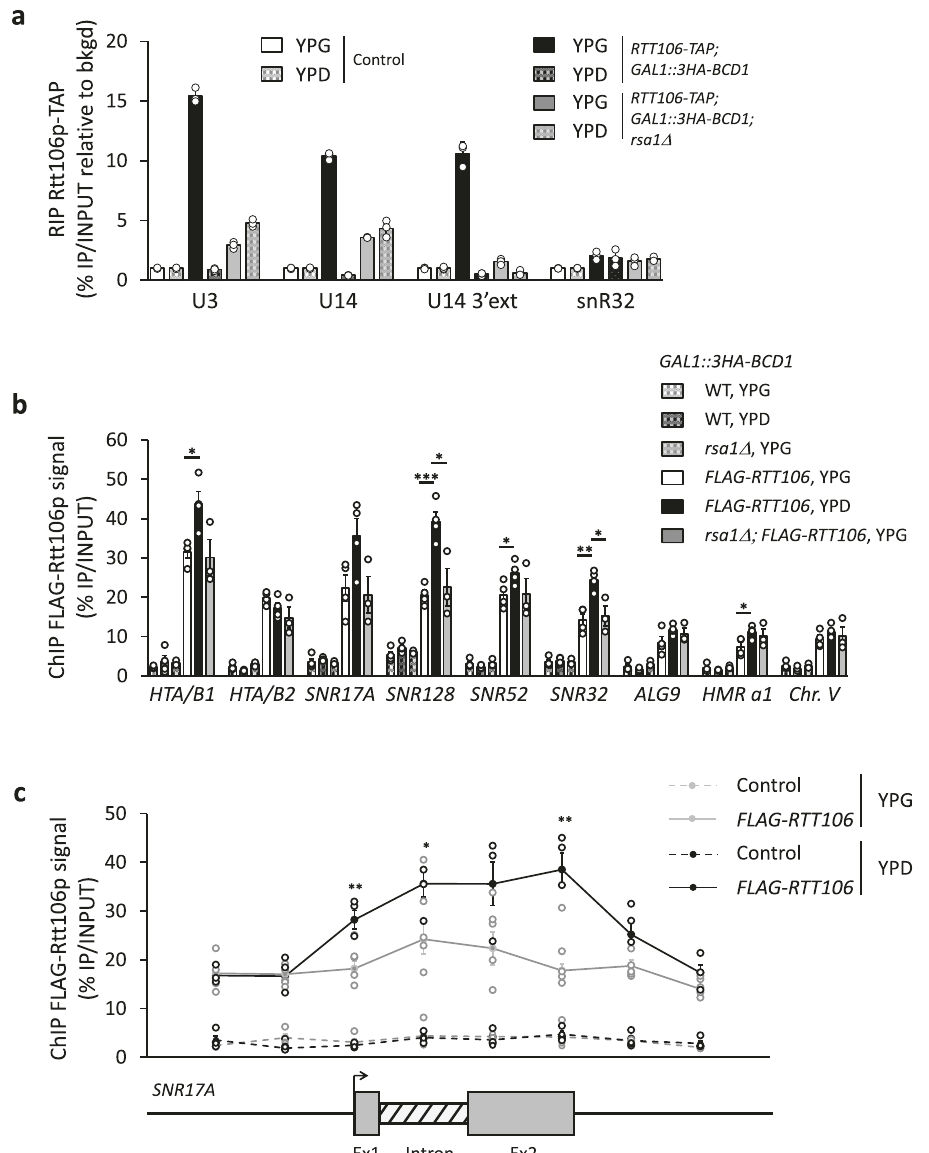
Fig. 3 Interaction of Rtt106p with selected transcripts and loci. a RNA immunoprecipitation (RIP) assays were performed on extracts prepared from RTT106-TAP ; GAL1:3HA-BCD1 cells disrupted ( rsa1 Δ ) or not of the RSA1 ORF. The cells were cultivated in the presence of galactose (YPG) or shifted to a glucose-containing medium (YPD) for 6 h before preparation of the extract. IP was performed using IgG-sepharose beads. RNAs retained on beads were quanti fi ed by RT-qPCR as described in the Methods section. The snoRNAs and pre-snoRNAs analyzed are indicated. b Chromatin immunoprecipitation (ChIP) assays were performed on yeast GAL1:3HA-BCD1 cells transformed with recombinant plasmid FLAG-RTT106 ; with ( rsa1 Δ ) or without the disruption of the RSA1 ORF. Cells were cultivated in YPG or shifted to YPD medium before ChIP assays. Cells expressing nontagged Rtt106p ( GAL1:3HA-BCD1 and GAL1:3HA-BCD1; rsa1 Δ ) were used as controls and IP was performed using anti-FLAG antibody. The loci analyzed by qPCR analysis are indicated. c Chip assays performed as in panel b on GAL1:3HA-BCD1 cells transformed with recombinant plasmid FLAG-RTT106 . Primers were used for qPCR analysis on both side and across the U3 encoding gene ( SNR17A ). Data reported in the panels a and c are mean values plus standard error of the mean of three biological replicates ( n = 3). Data reported in panel b are mean values plus standard error of the mean of three (for GAL1::3HA-BCD1, rsa1 Δ + p413 ( − ) and GAL1::3HA-BCD1, rsa1 Δ + p413:: FLAG-RTT106 ; n = 3) or four (for GAL1::3HA-BCD1 + p413 ( − ) and GAL1::3HA-BCD1 + p413:: FLAG-RTT106 ; n = 4) biological replicates. Two-tailed t -tests: * P < 0.05, ** P < 0.01, *** P < 0.001. In panel b , for FLAG-RTT106 YPG versus YPD: * = 0.012 for HTA/B1 , *** = 0.0006 for SNR128 (U14), * = 0.045 for SNR52 , ** = 0.002 for SNR32 , * = 0.032 for HMR a1 . Note that SNR17A (U3) is close to signi fi cance: P = 0,056. For FLAG-RTT106 YPG versus rsa1 Δ ; FLAG-RTT106 YPG: * = 0.02 for SNR128 (U14) and * = 0.017 for SNR32 . In panel c , for FLAG-RTT106 YPG versus